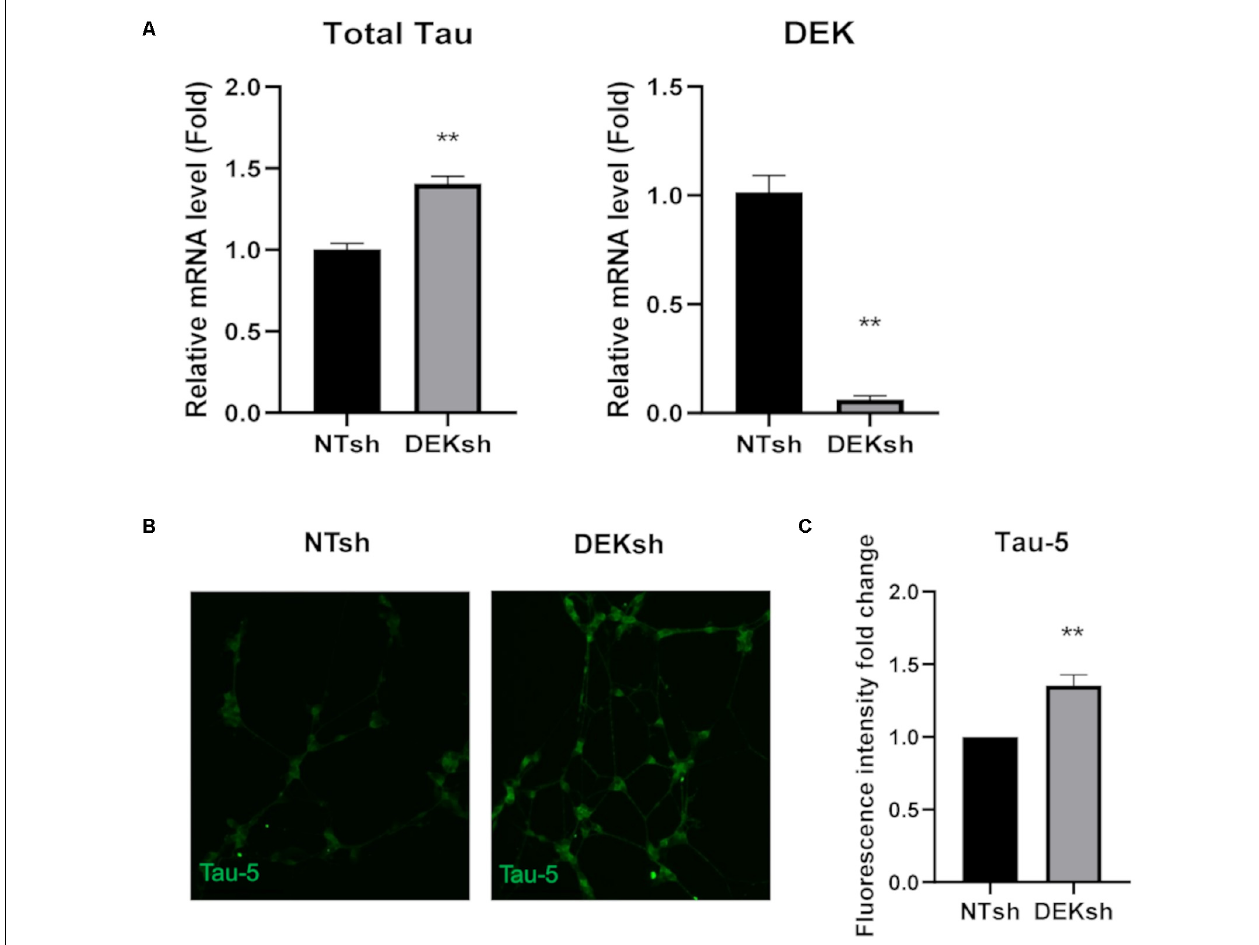
FIGURE 3 | DEK loss causes increased unphosphorylated Tau expression in differentiated SH-SY5Y cells. (A) Relative mRNA expression of Tau is increased in DEKsh cells, while DEK is confirmed to be transcriptionally downregulated (** p < 0.01). (B,C) The fluorescent intensity of the total Tau (Tau-5) expression is significantly higher in DEKsh cells (** p <